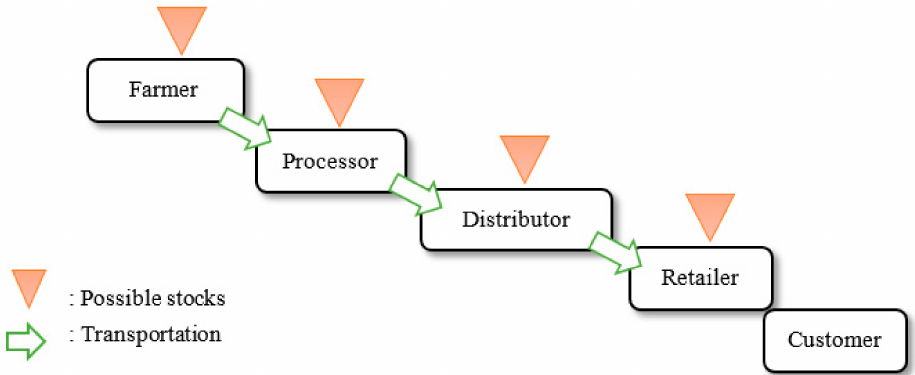
Figure 1. Generic AFSCs (based on